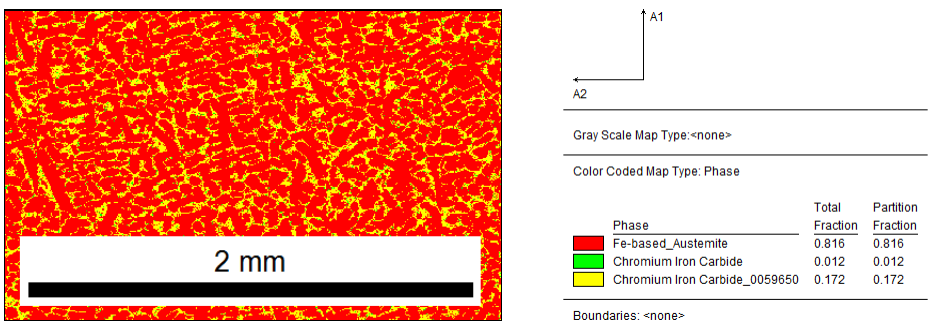
Figure 6. Inoculated sample with 0.17% Fe – Ti: distribution map of occurring phases, yellow area — M 7 C 3 , green area — M 3 C.